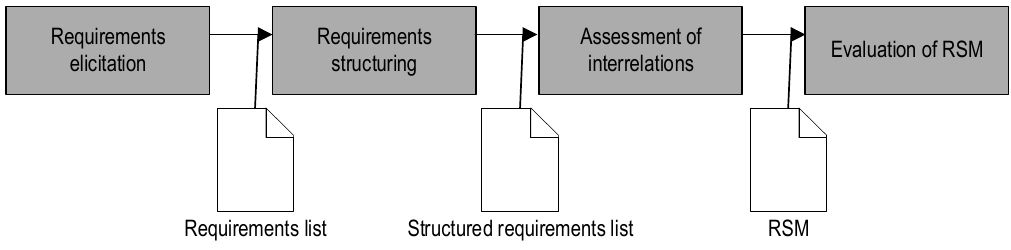
Figure 7. Process for semi-automatized assessment of requirement interrelations [51].